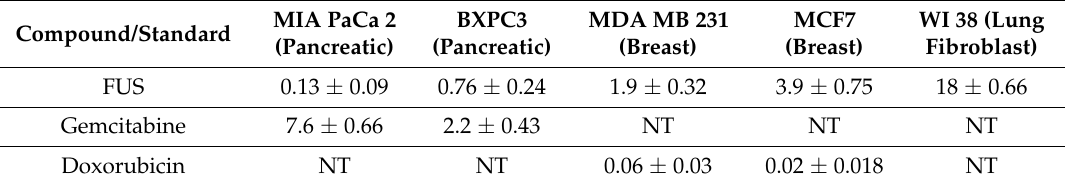
Figure 2. MTT cell-viability assay profile in pancreatic (MIA PaCa2 and BXPC3) and breast (MDA MB 231 and MCF7) cancer cell lines treated with FUS for 24 h. Table 1. Cytotoxicity assay results of FUS against human tumor cells (IC 50 in µ